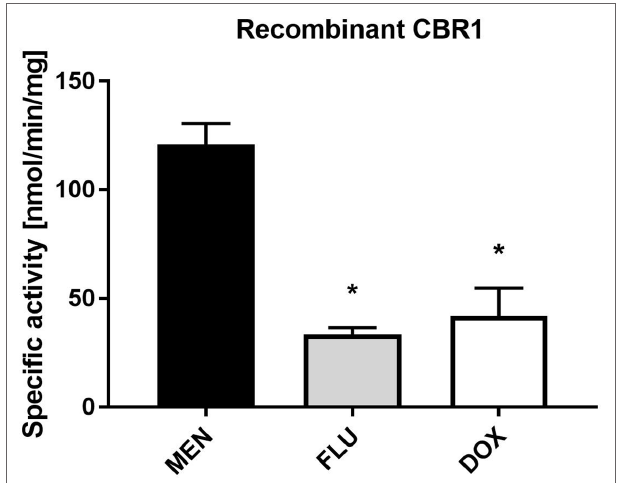
FIGURE 5 | Specific activity of human recombinant CBR1 toward menadione (MEN), flubendazole (FLU), and doxorubicin (DOX). CBR1 was incubated with 10 µM substrates (MEN, FLU, and DOX). The values represent the mean ± standard deviation of three independent experiments. *Significantly different compared with